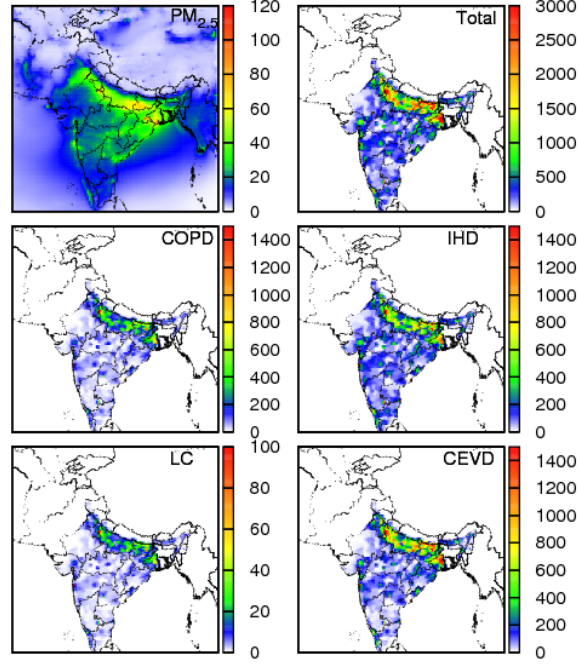
Figure 1. Predicted annual PM 2 . 5 concentrations (µgm − 3 ), total premature mortality (death per grid of 36 × 36km 2 ), and premature mortality due to COPD, LC, IHD and CEVD in India for 2015.